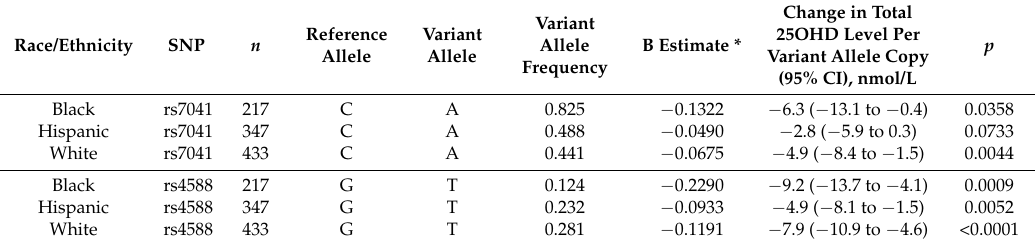
Table A1. Sensitivity analysis: Association of Vitamin D-binding protein Genetic Polymorphisms and serum 25OHD levels by race/ethnicity excluding subjects using vitamin-D supplements at the time of 25OHD